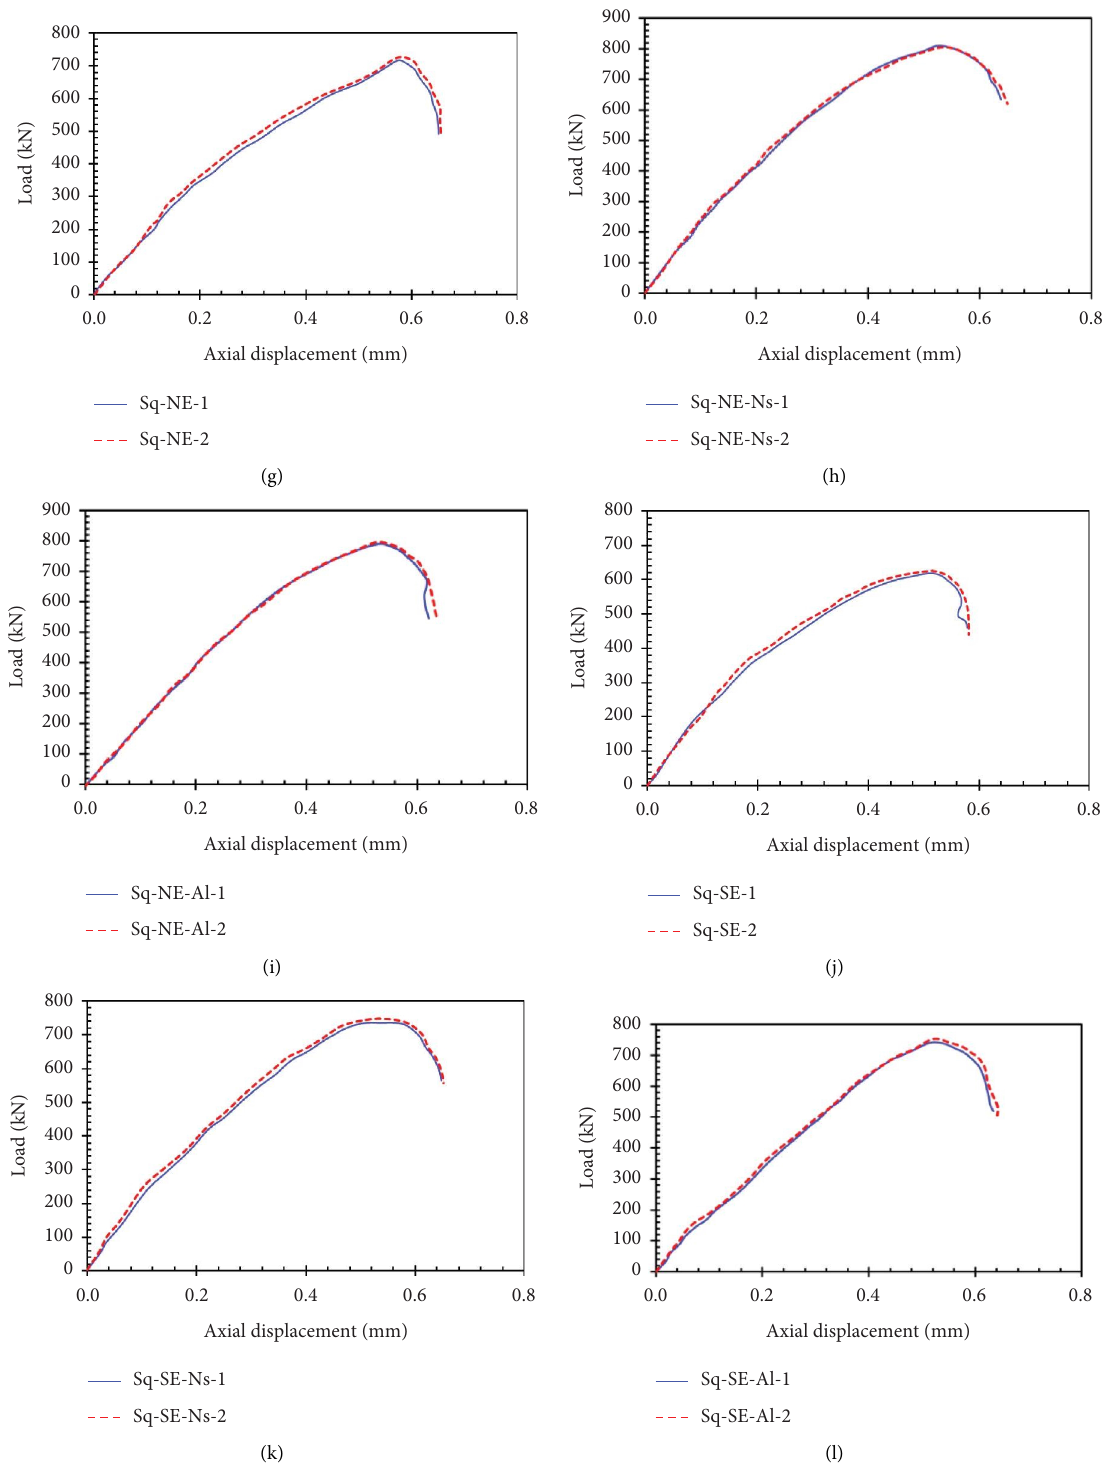
Figure 7: Te load-defection curves of the columns: (a) Ci-NE, (b) Ci-NE-Ns, (c) Ci-NE-Al, (d) Ci-SE, (e) Ci-SE-Ns, (f) Ci-SE-Al, (g) Sq- NE, (h) Sq-NE-Ns, (i) Sq-NE-Al, (j) Sq-SE, (k) Sq-SE-Ns, and (l)